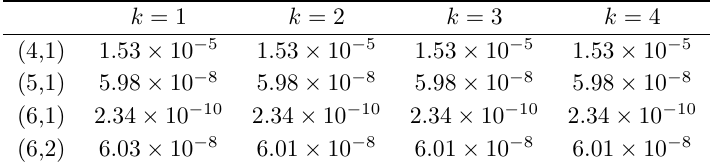
Table 10: Probabilities of generating undetectable faults for Exp 254 .